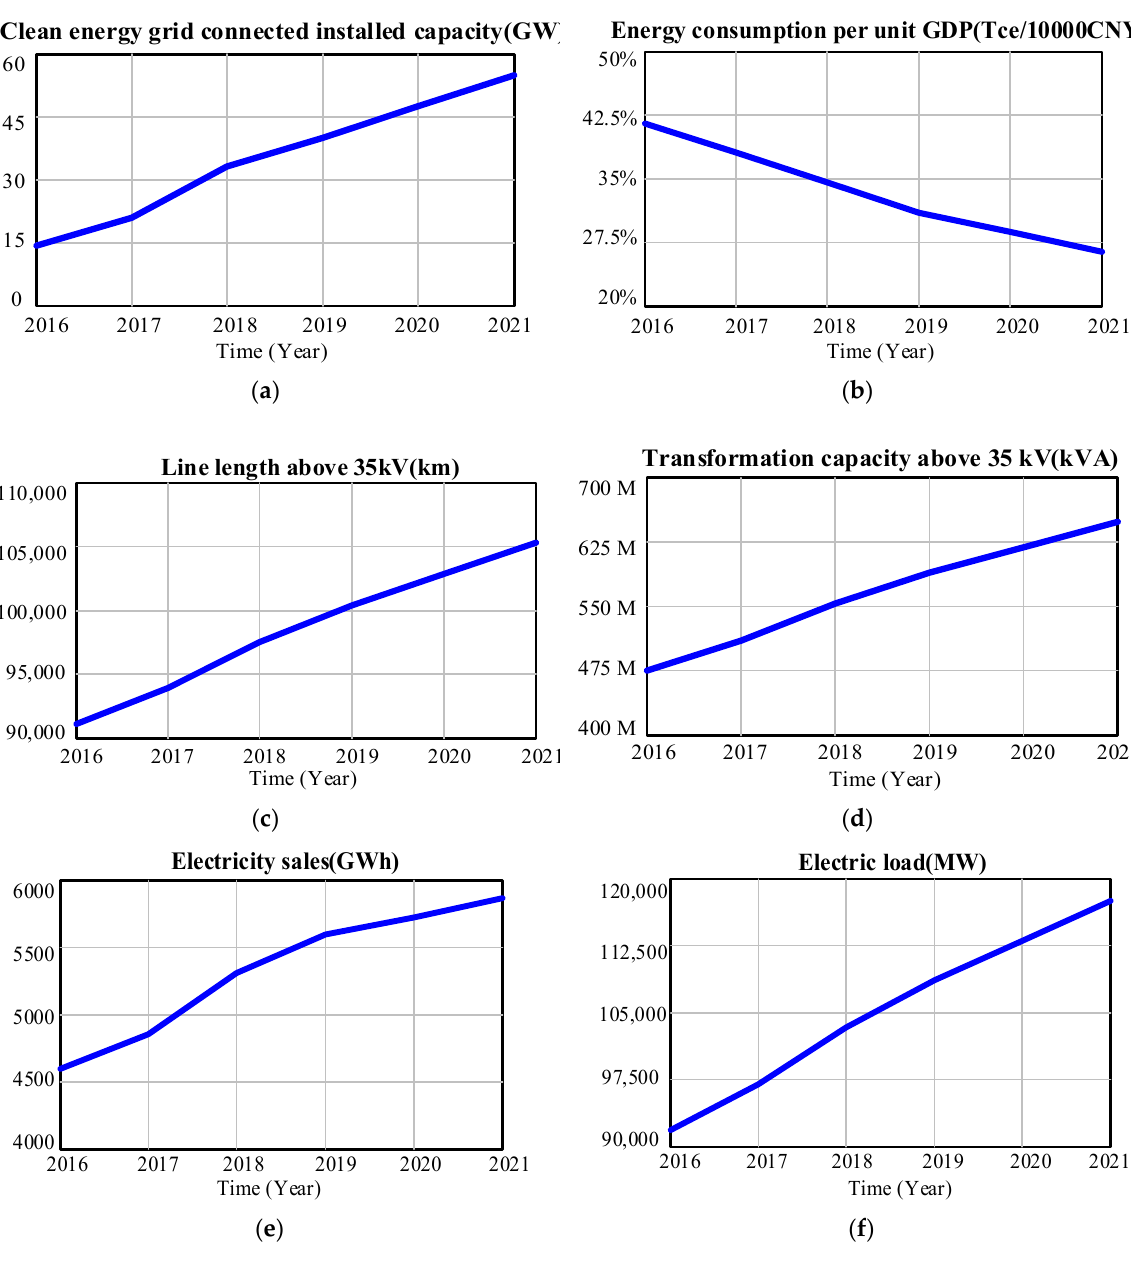
Table 3. Comparison between simulation value and actual value of key indicators of environmental investment.